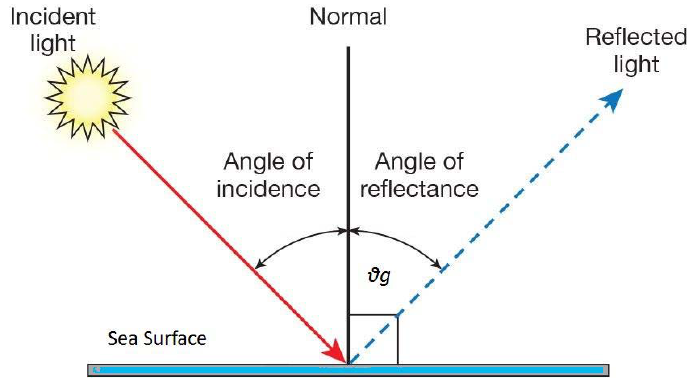
algorithm is based on average values of T b 3.9 , ∆ T and their standard deviations ( δ T